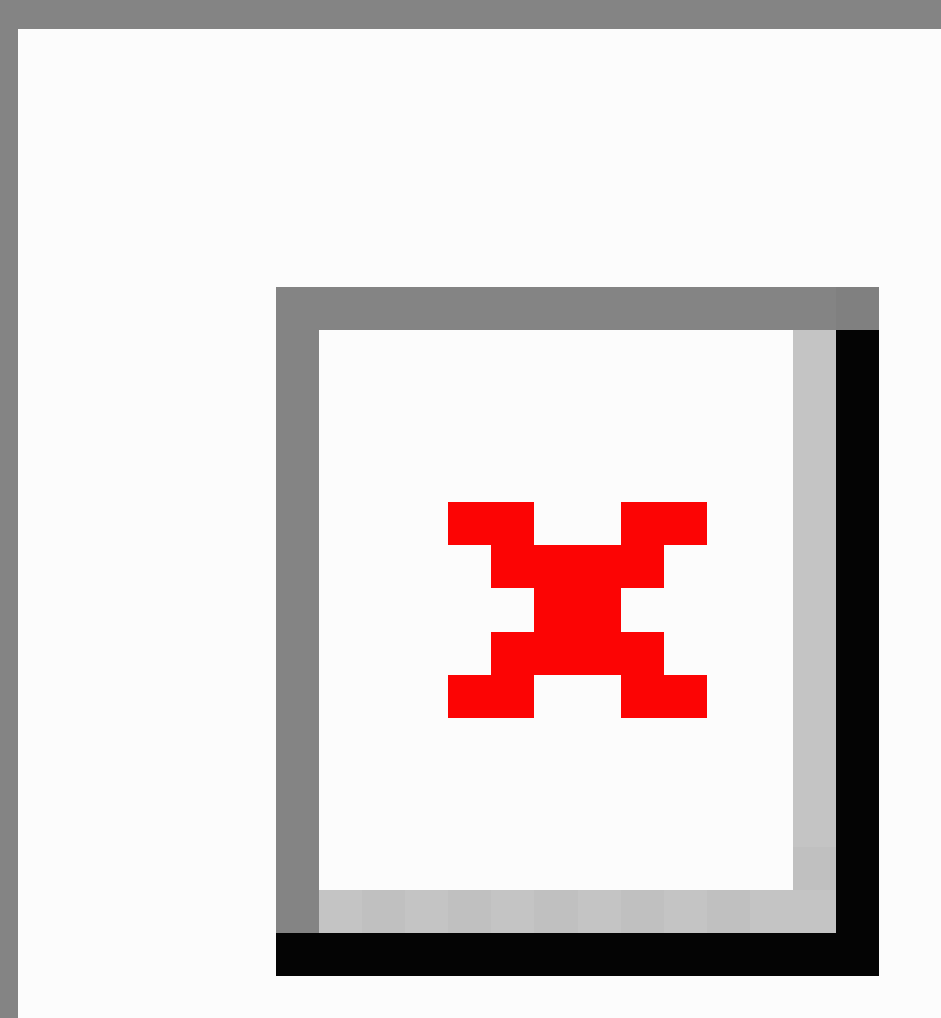
Figure 2. Overview of the study design and outcomes. PrEP: pre-exposure